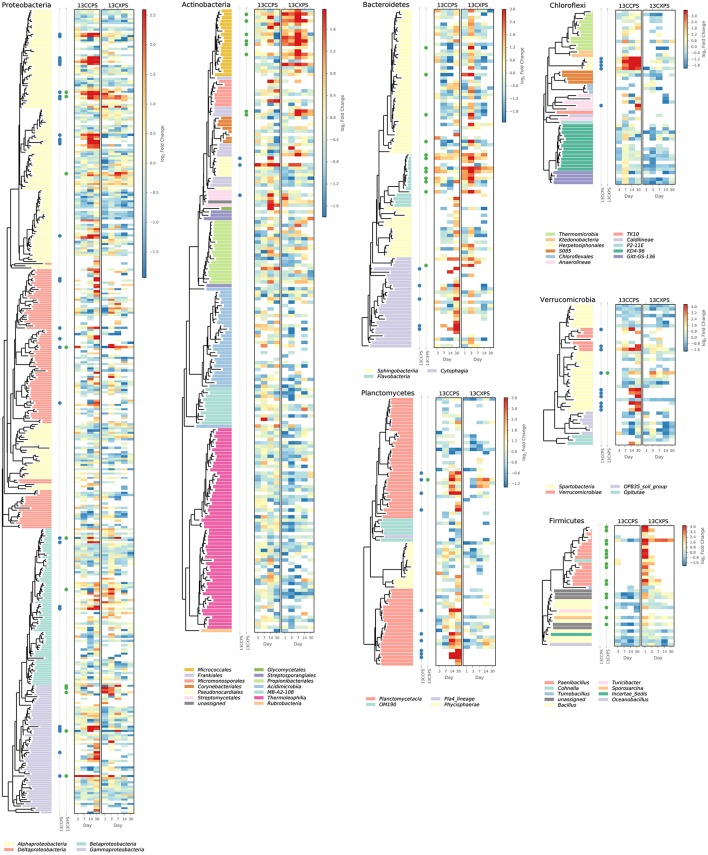
Phylogenetic position of cellulose responders and xylose responders in the context of all OTUs that passed sparsity independent filtering criteria (see Methods). Only those phyla that contain responders are shown. Colored dots are used to identify xylose responders (green) and cellulose responders (blue). The heatmaps indicate enrichment in high density fractions relative to control (represented as LFC) for each OTU in response to both 13C-cellulose (13CCPS, leftmost heatmap) and 13C-xylose (13CXPS, rightmost heatmap) with values for different days in each heatmap column. High enrichment values (represented as LFC) provide evidence of 13C-labeled DNA.